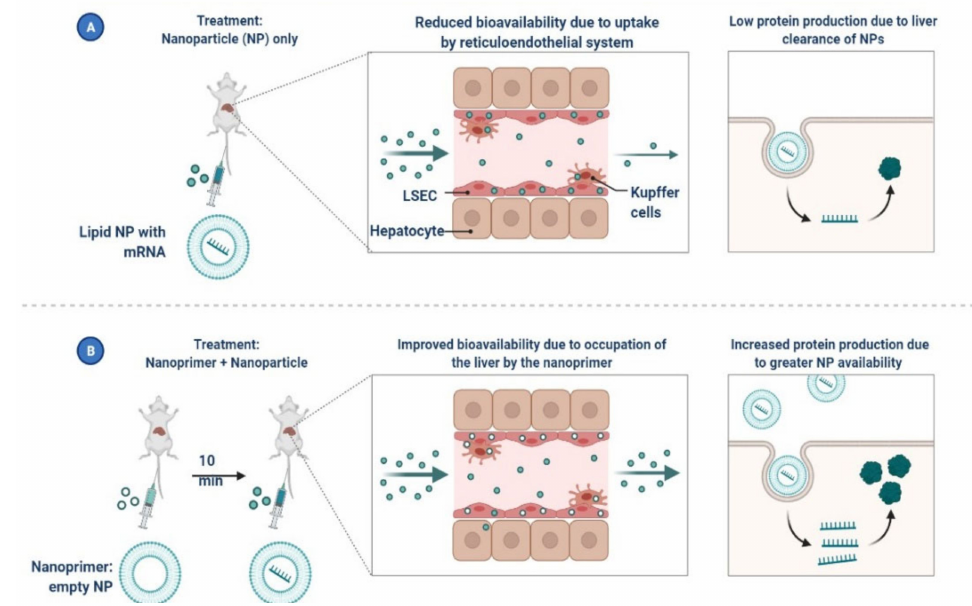
Figure 26. A Nanoprimer to Improve the Systemic Delivery of mRNA-Containing